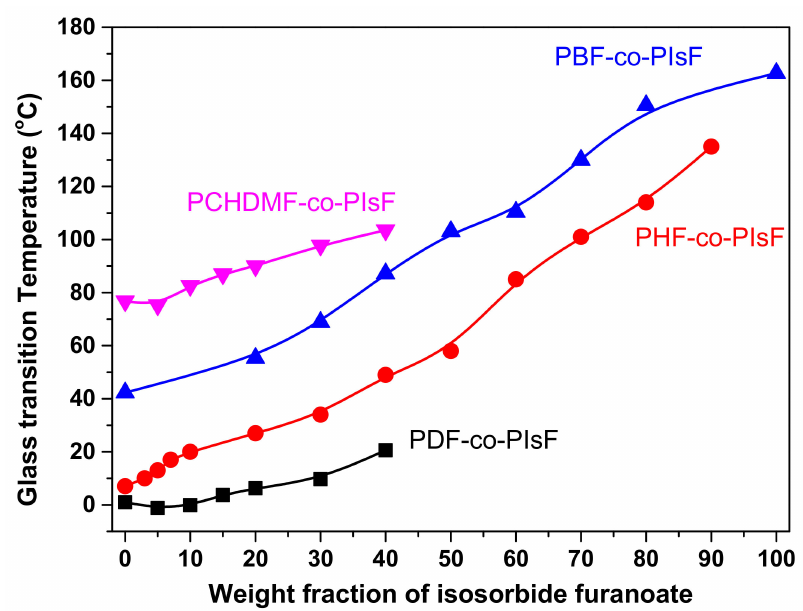
Figure 2. E ff ect of isosorbide furanoate content on the T g of furan-based copolyesters. Data adopted from bibliography [68,97,99,100]. The lines are to guide the